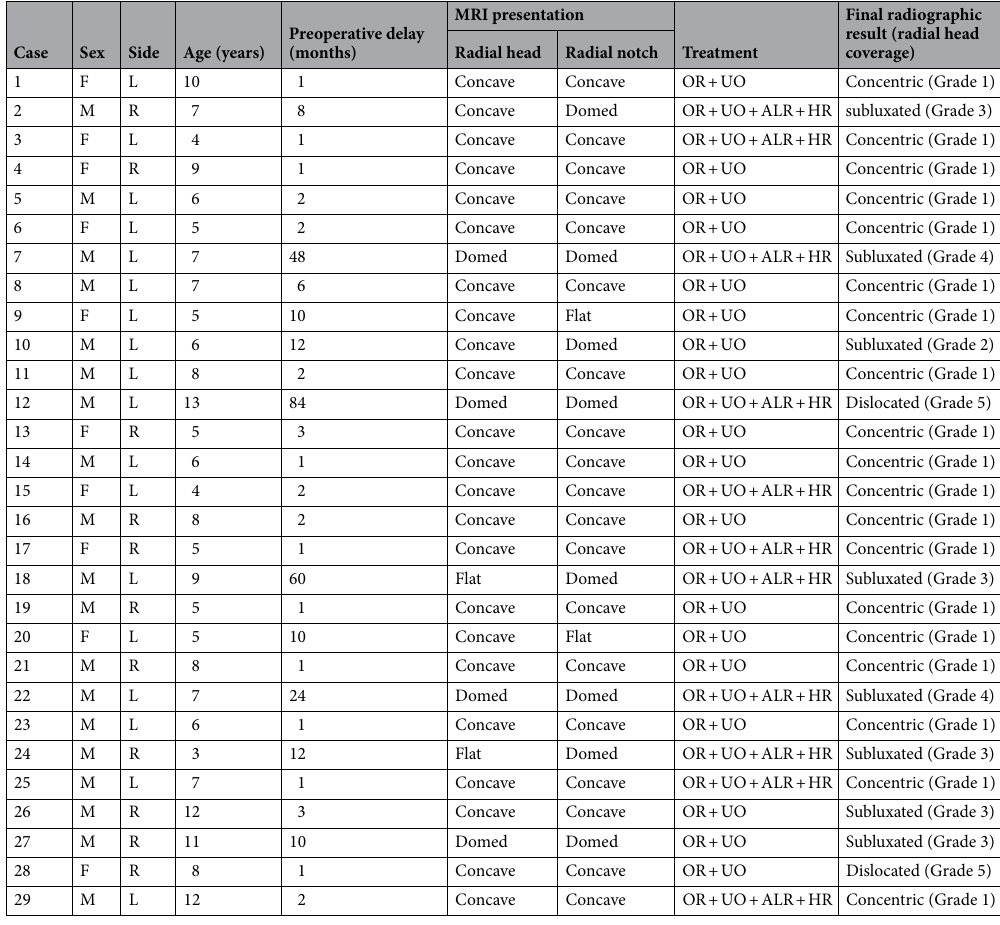
Table 1. Demographic data of the 29 children. UO ulnar osteotomy, OR open reduction of radial head, ALR annular ligament reconstruction, HR humeroradial